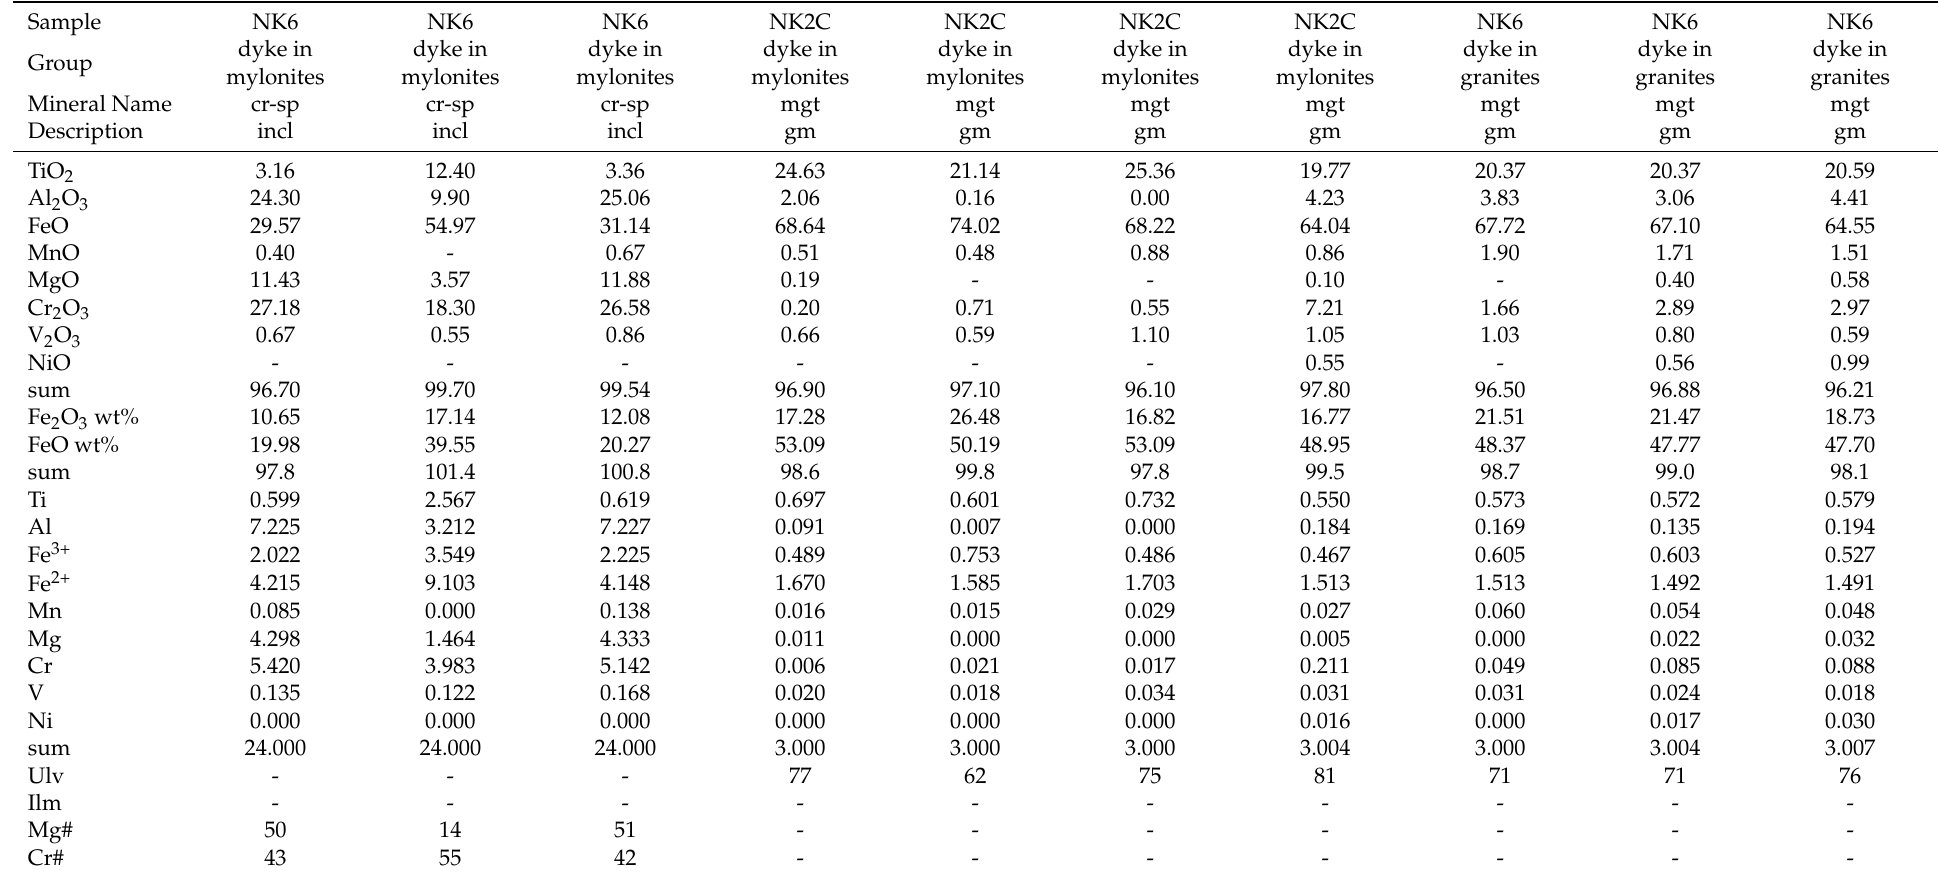
Table 3. Representative chemical analyses (in wt.%) and structural formulas of chromiferous spinels, magnetites, and ilmenites of Njimom dykes (western